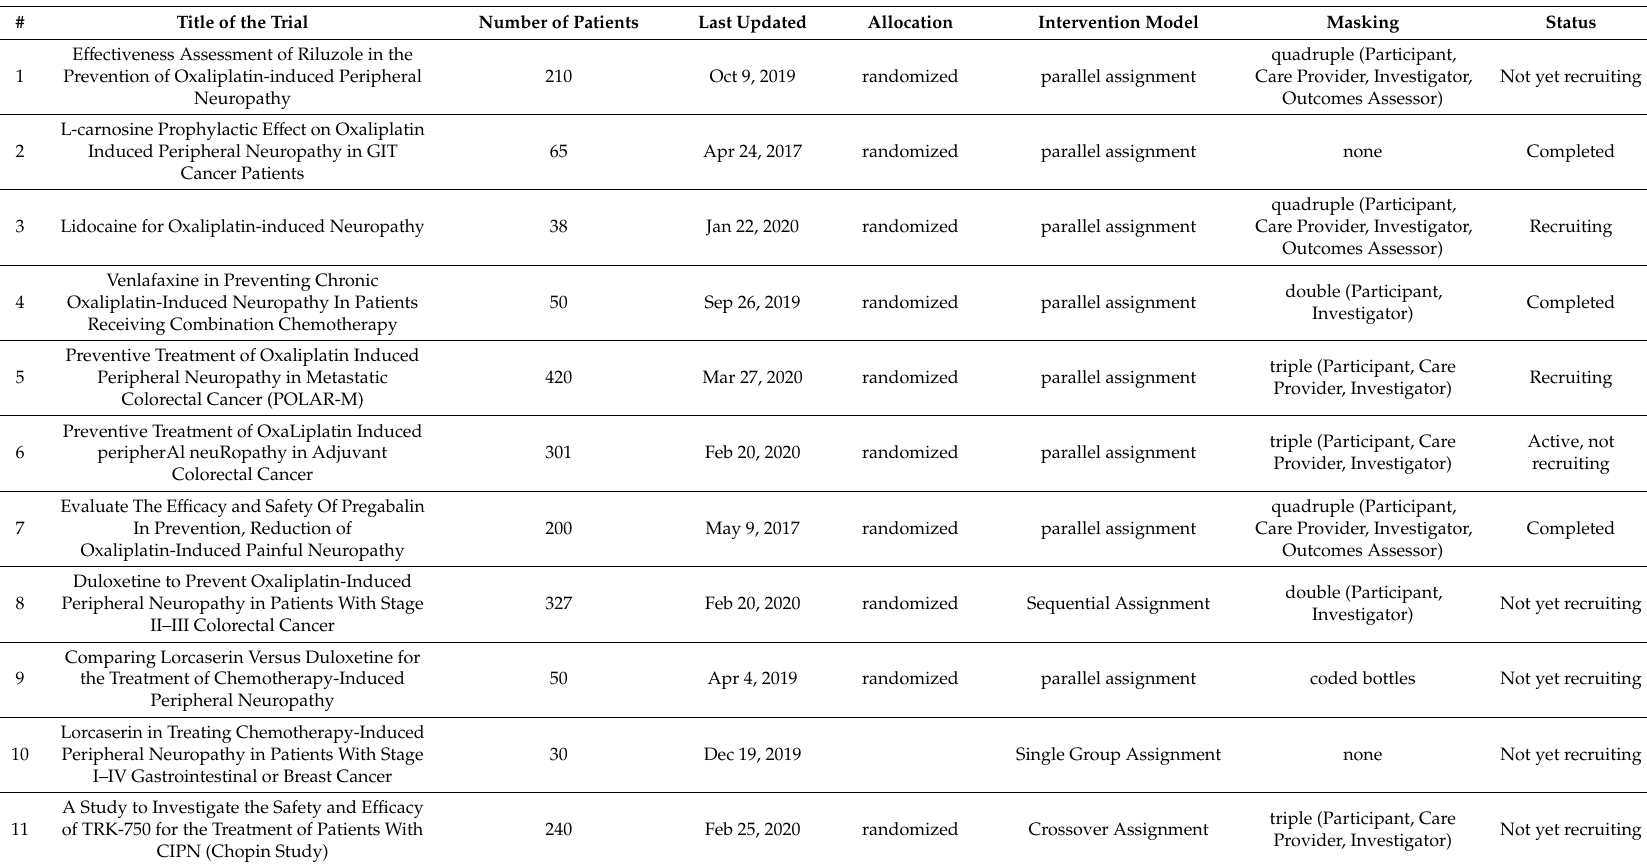
Table 1. Pharmacological studies including oxaliplatin-treated patients registered at ClinicalTrial.gov on 1 April